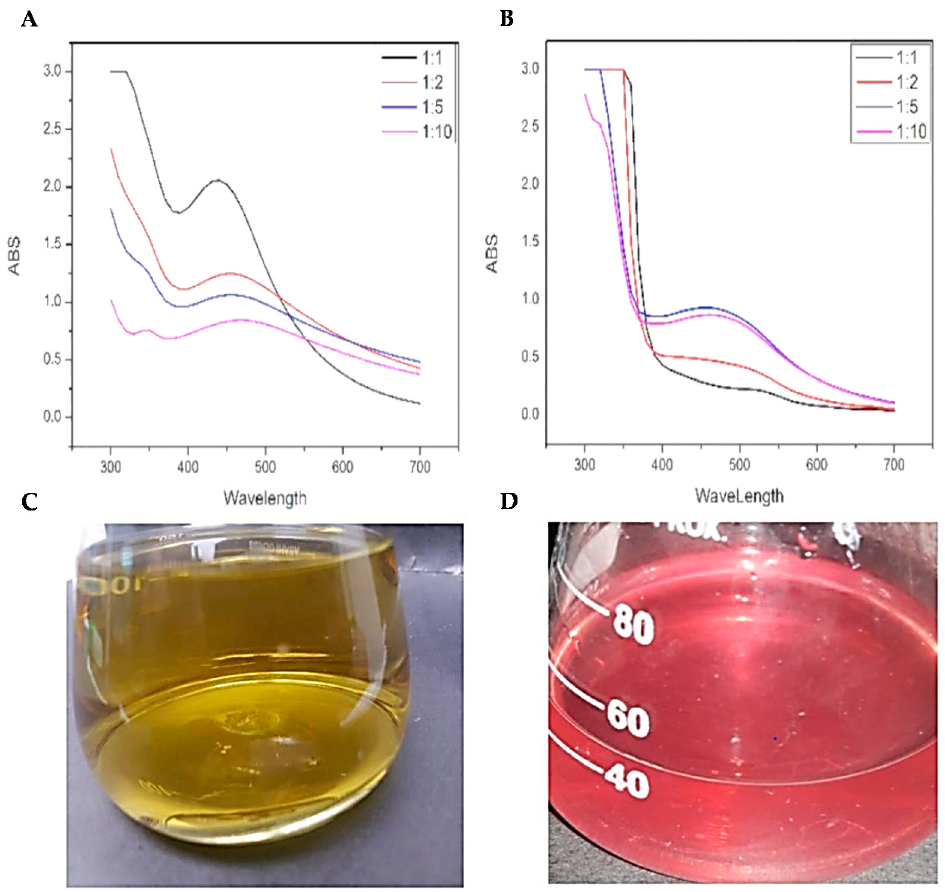
Figure 1. ( A ) UV-Vis spectral analysis of BC-AgNPs; ( B ) UV-Vis spectral analysis of AE-AgNPs; ( C ) optical observation of green synthesized callus extract; ( D ) optical observation green synthesized anthocyanin extract.